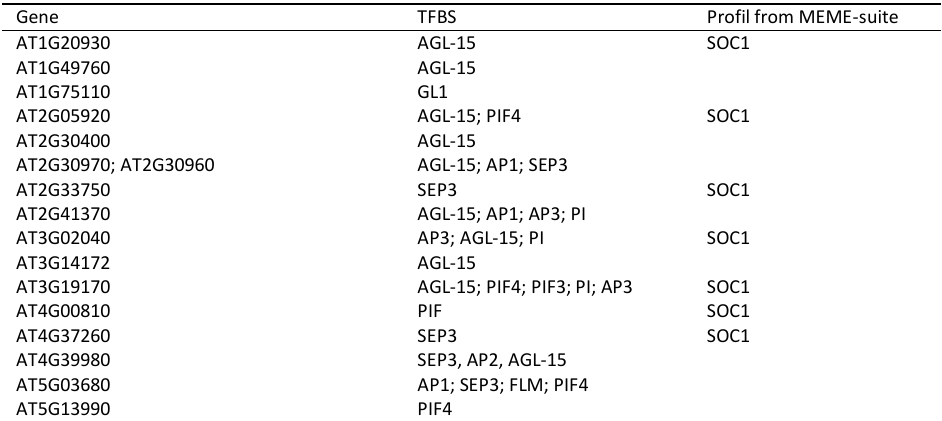
Table 5: Sixteen floral regulators genes from Chen et al. (Chen et al., 2018) with a Duster-specific region in the 500 bp immediately upstream, colocalizing with highly conserved CNSs and TFBSs Gene TFBS Profil from MEME-suite AT1G20930